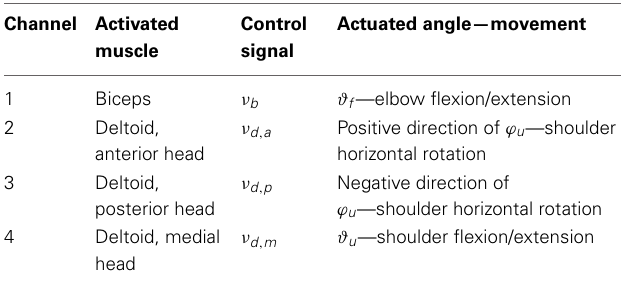
Table 1 | Stimulation